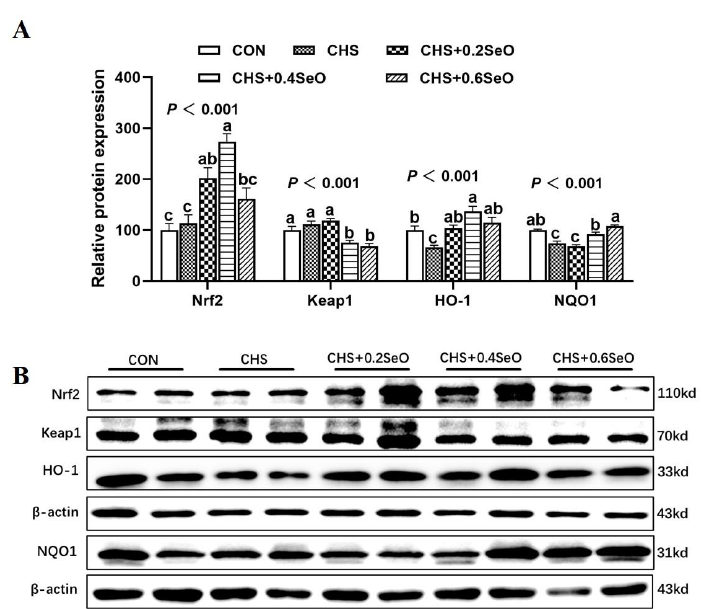
Figure 3. Effects of CHS and SeO supplementation on the abundance of protein related to Nrf2 signal in the spleen. ( A ) Relative protein expression level, ( B ) Relevant protein bands. The results were expressed as mean ± SEM ( n = 6). Different letters (a, b and c) denote significant differences ( p < 0.05).